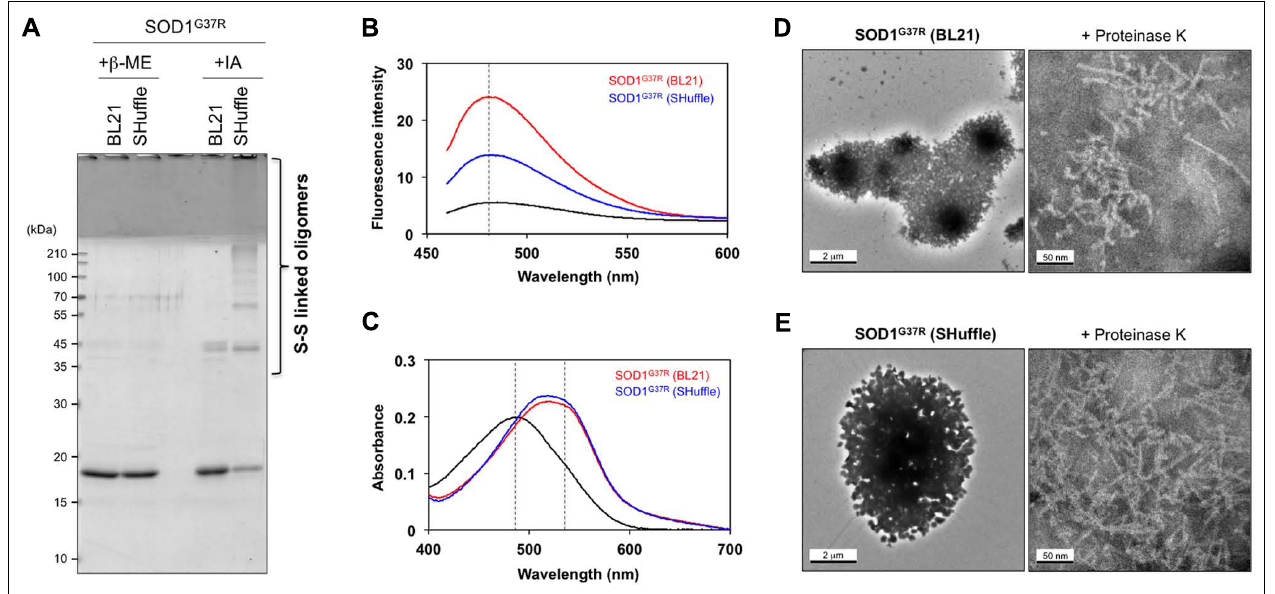
FIGURE 4 |Amyloid-like characters of SOD1 aggregates purified from insoluble inclusions in E. coli . (A) SOD1(G37R) aggregates purified from insoluble inclusions in E. coli were reacted with iodoacetamide for protection of free thiol groups and analyzed with reducing ( + β -ME) and non-reducing ( + IA) SDS-PAGE. Disulfide-crosslinked oligomers were identified in SOD1(G37R) aggregates purified from insoluble inclusions in E. coli SHuffle TM but not in BL21(DE3). (B, C) Tinctorial properties of SOD1(G37R) aggregates purified from E. coli BL21 and SHuffle TM (red and blue curves,